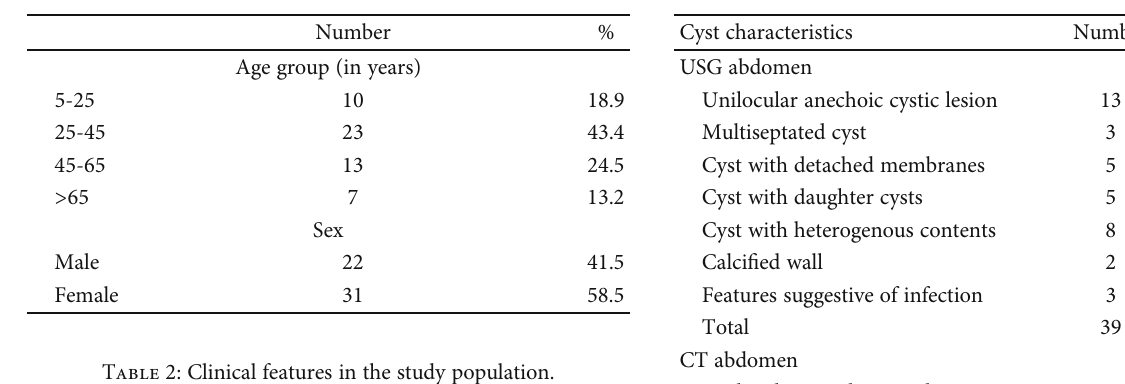
Table 1: Demographics of the study population ( n = 53 ).